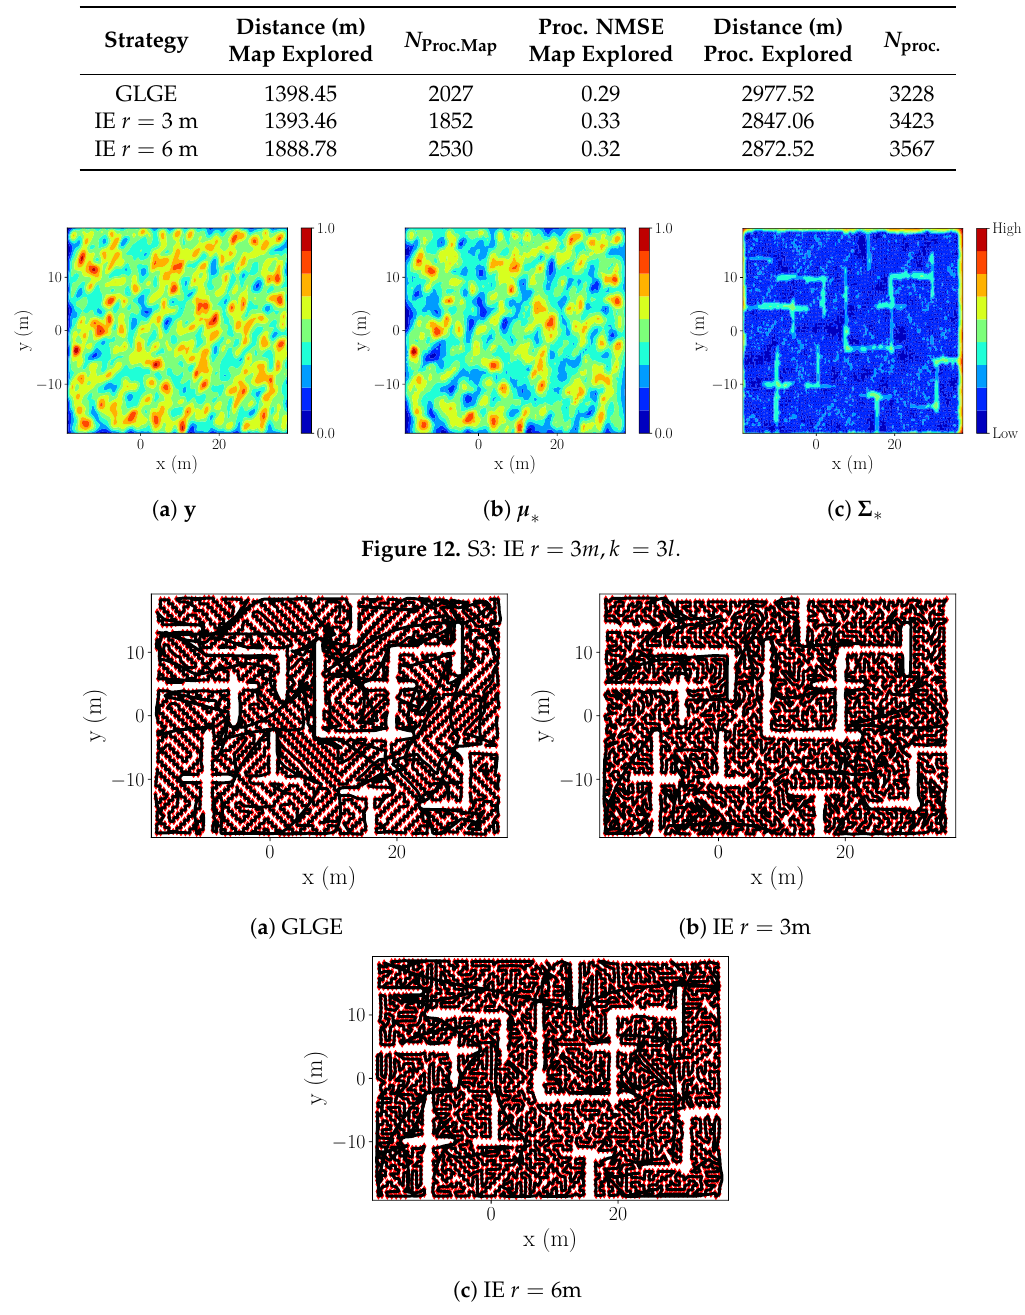
Figure 13. S3: Trajectories (black lines) and obtained measurements (red